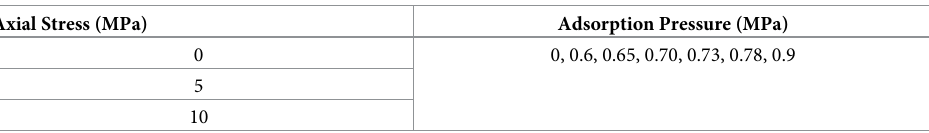
Table 1. Experimental